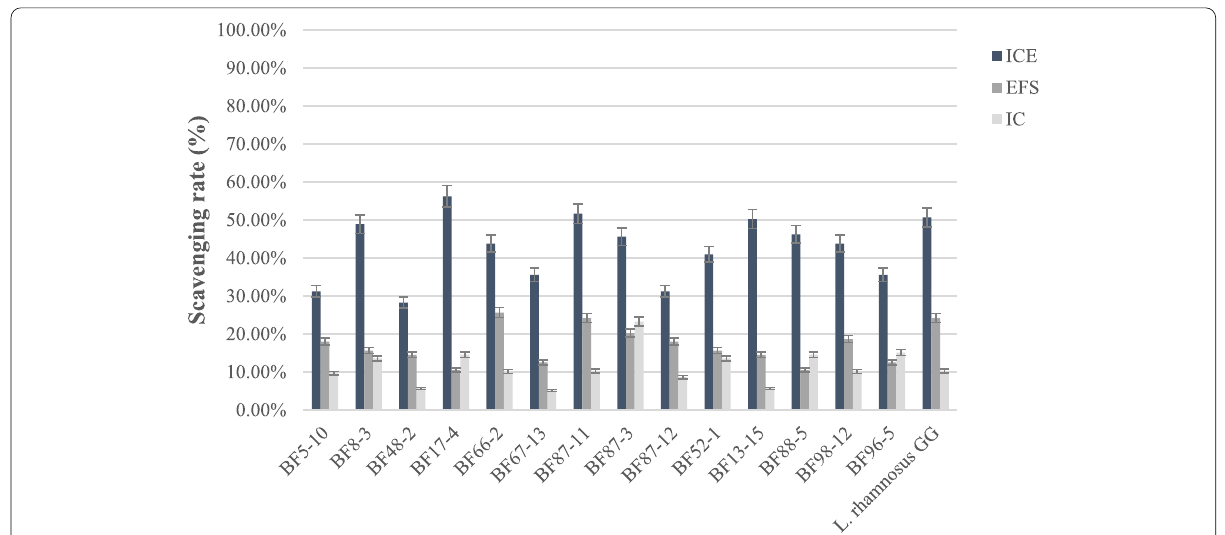
Fig. 4 The ability of the Bifidobacterium strains’ intracellular cell extract (ICE), extracellular fermentation supernatant (EFS), and intact cells (IC) to scavenge DPPH free radicals. (Error bars indicate standard deviation from three independent